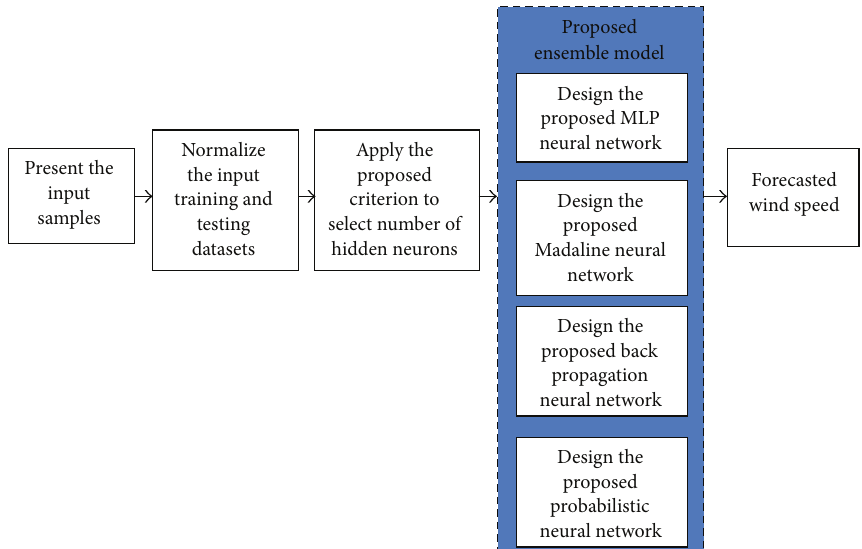
Figure 1: Basic block diagram of the proposed ensemble neural network